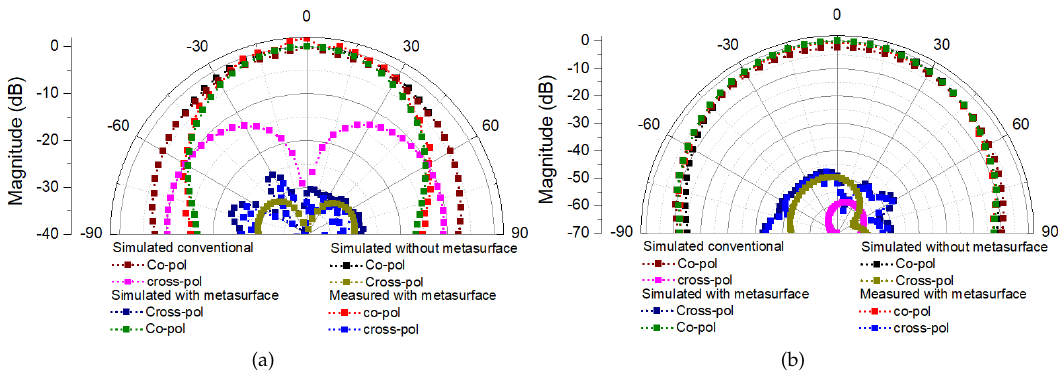
Figure 14. Broadside radiation pattern of the conventional, with and without metasurface integrated antenna at 2.2 GHz ( a ) E-plane ( φ − 0 ◦ ) ( b ) H-plane ( φ − 90 ◦